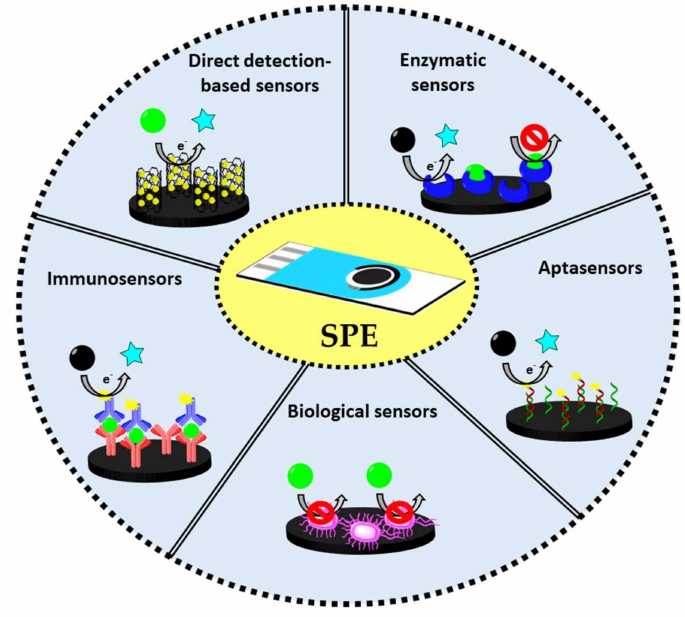
Figure 1. Main (bio)sensing routes followed for the electrochemical detection of